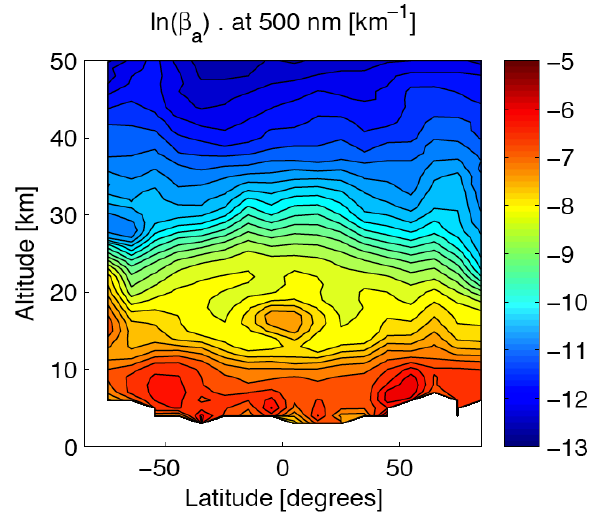
Fig. 43. The natural logarithm of the 500 nm aerosol extinction median values for the year 2003 (km -1 ). The isolated feature at the equator (15-17 km) is due to sub-visible equatorial cirrus, while PSCs are mostly seen in the South polar vortex, and barely visible in the North polar vortex (from Vanhellemont et al., 2005)